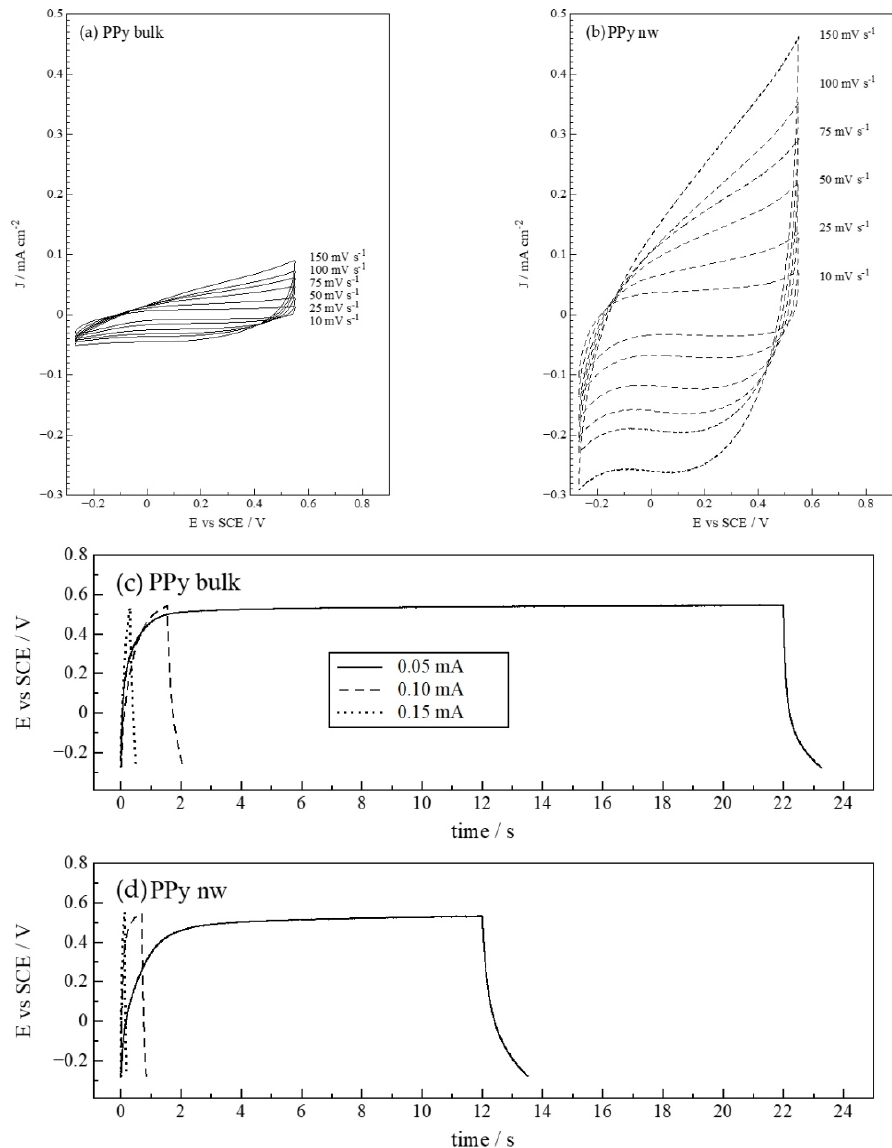
Figure 2. Electrode characterization in aqueous medium with LiCl 0.100 mol L − 1 : ( a , b ) cyclic voltammetry at different scan rates. ( c , d ) Galvanostatic measurements at different currents.